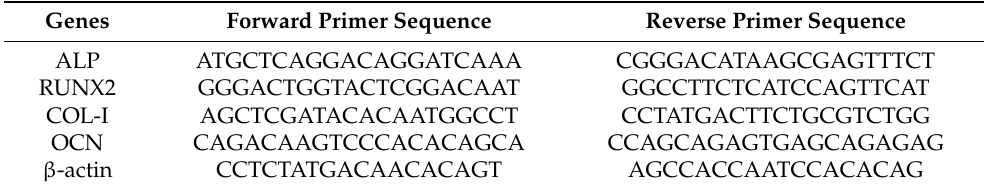
Table 1. The primers used for the evaluation of osteogenesis-related gene expression in BMSCs.